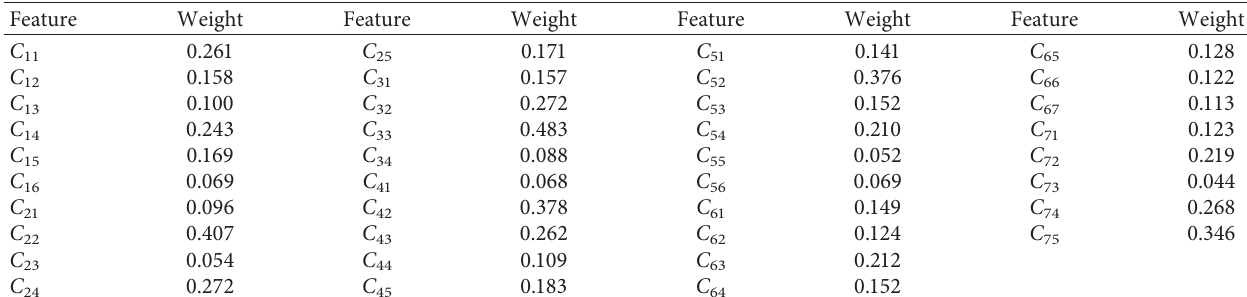
Table 4: Weights of matter-element